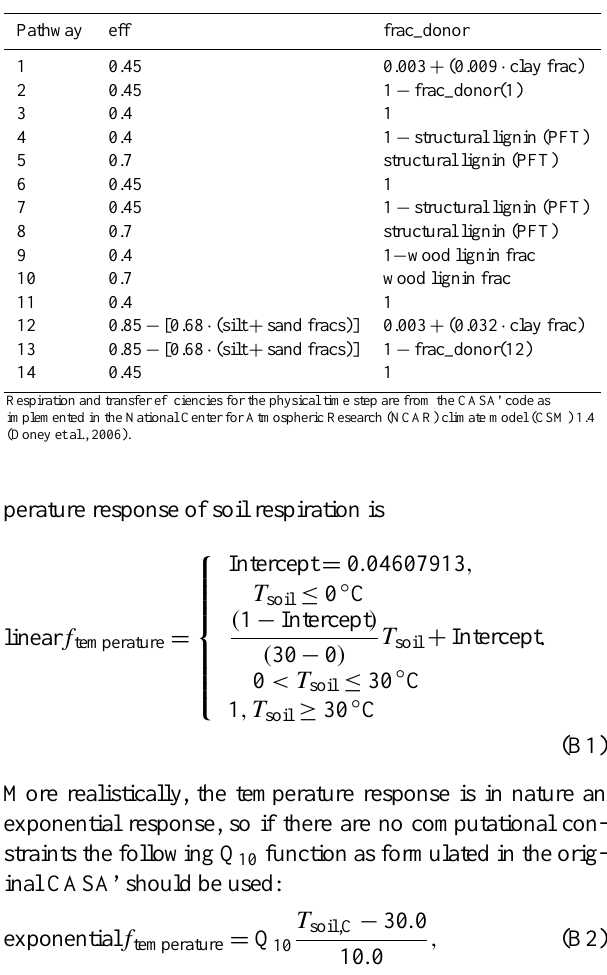
Table B2. Values of respiration pathway coefficients: eff – micro- bial respiration transfer efficiencies for all 14 pathways; frac_donor – additional respiration efficiencies (both